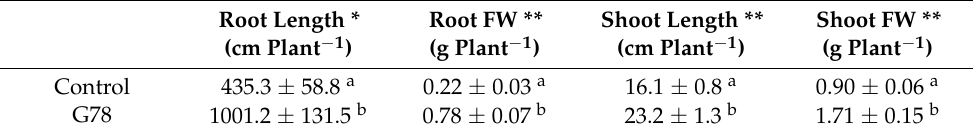
Table 2. Effects of P. mucilaginosus G78 strain on the growth of tomato